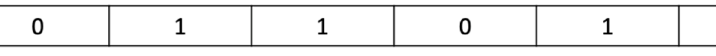
Figure 1. Representation of a solution.